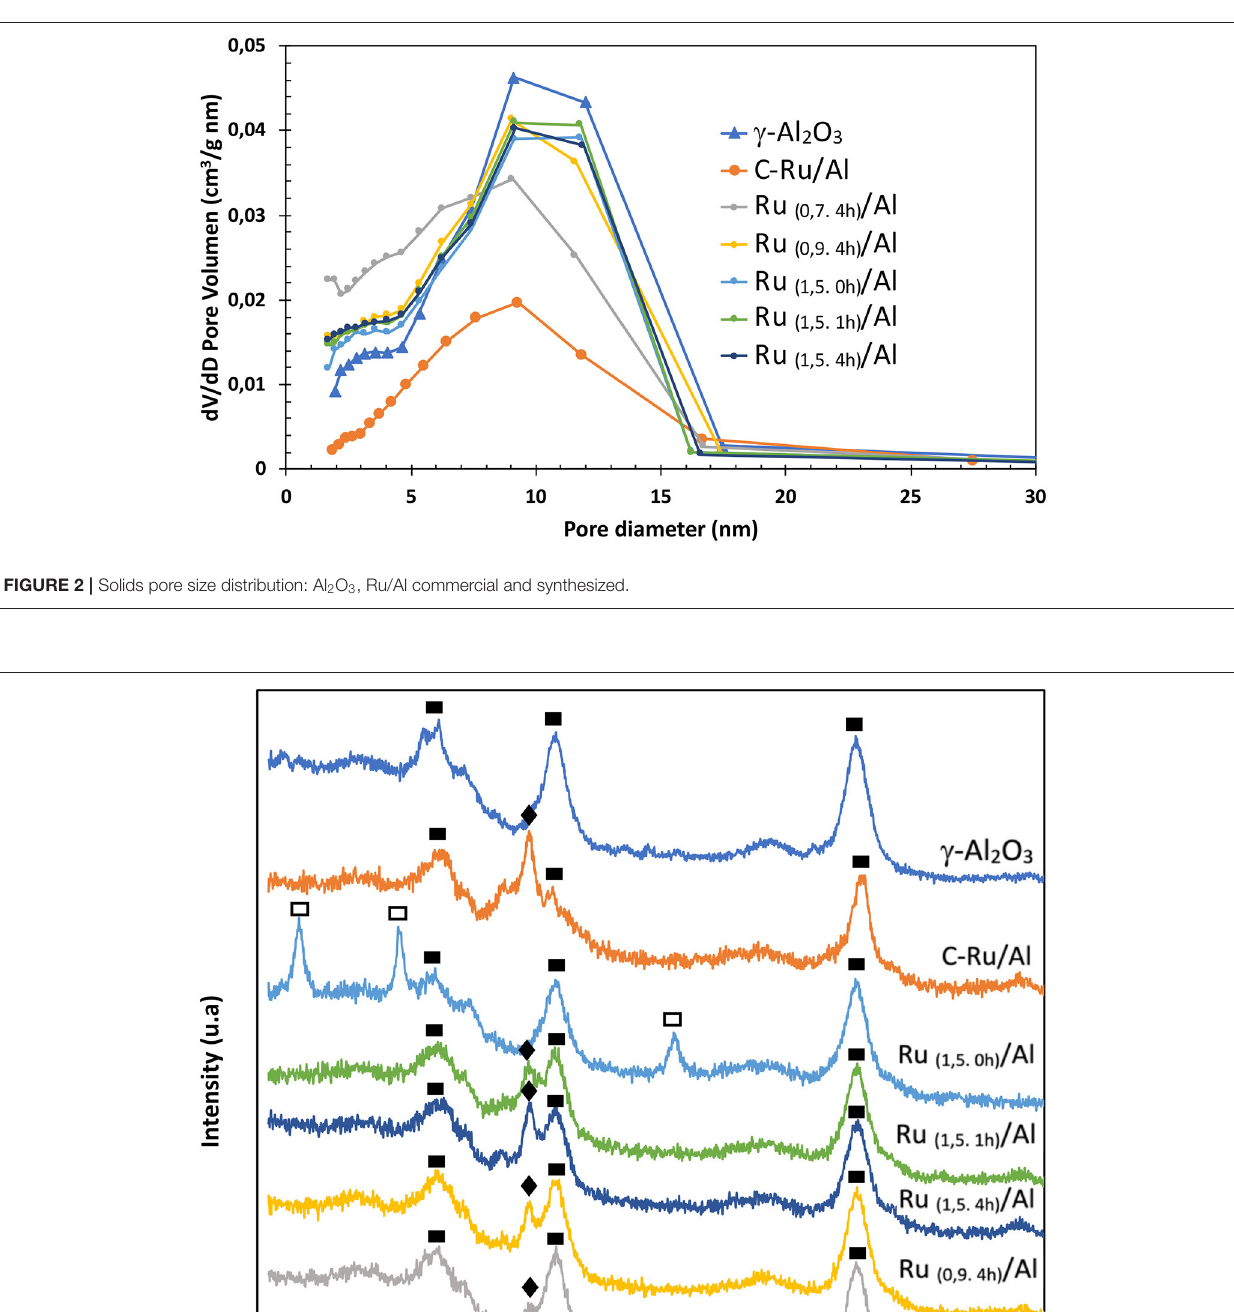
Frontiers in Chemistry |